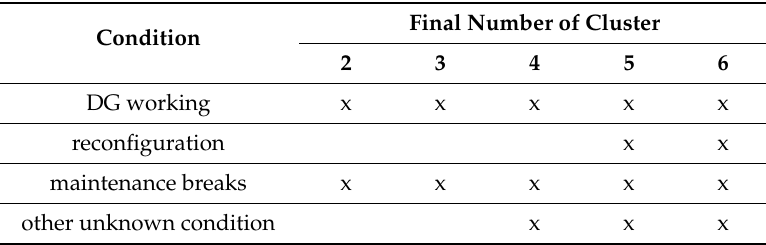
Table 1. The connection between the number of clusters and the working conditions of the electrical power network.